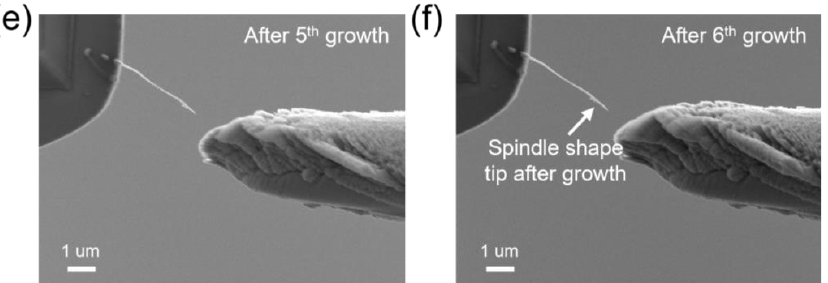
Figure 5. Growth of the Pt shell with the FEID method. ( a ) SEM image after the first two-minute growth, with the as-prepared isolated MWCNT acting as a cathode and the new tungsten probe acting as an anode; ( b ) SEM image after the second growth, the deposition can be found on the surface of the anode; ( c – e ) SEM images of the MWCNT after the third, fourth, and fifth growth; ( f ) image of the electrodes (the hybrid nanowire and the tungsten probe) after Pt shell preparation.